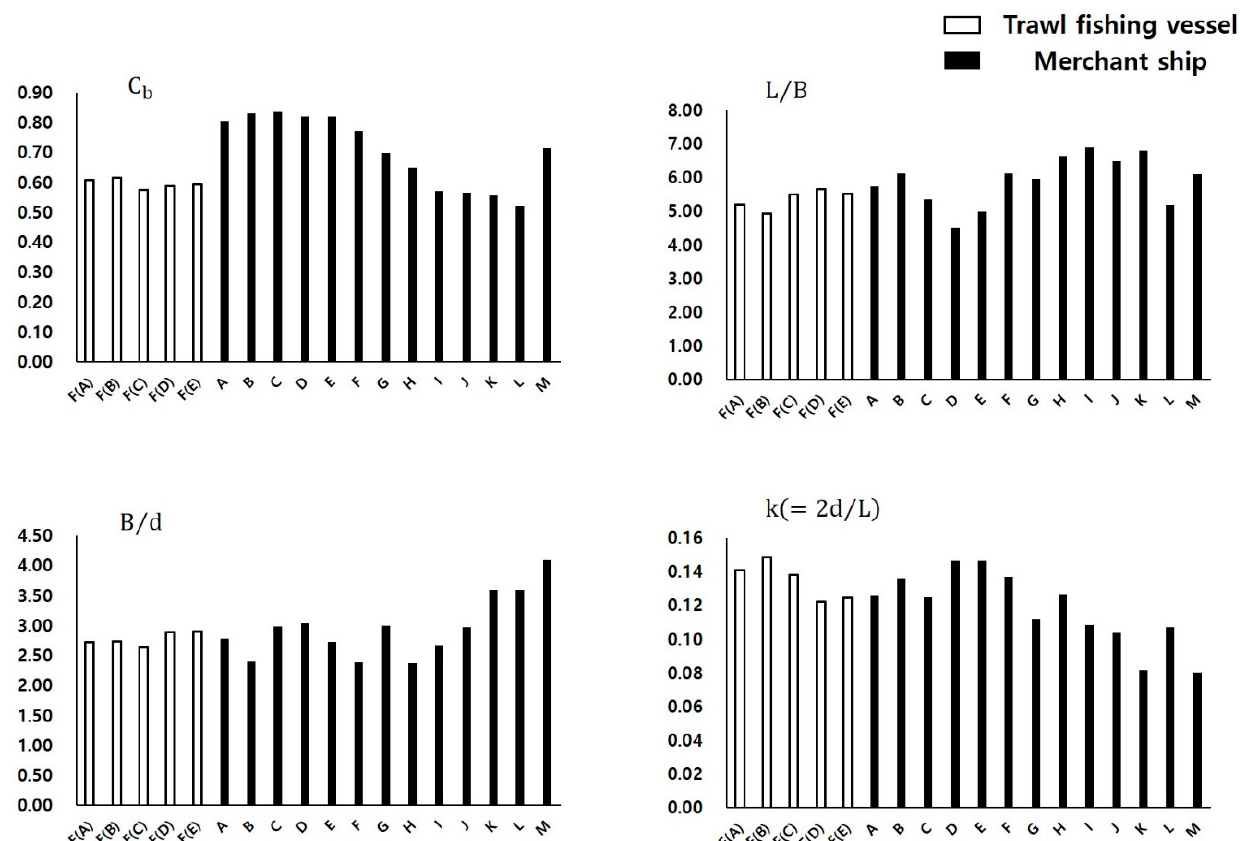
Figure 3. Comparison of the hull form parameters of the model ships.